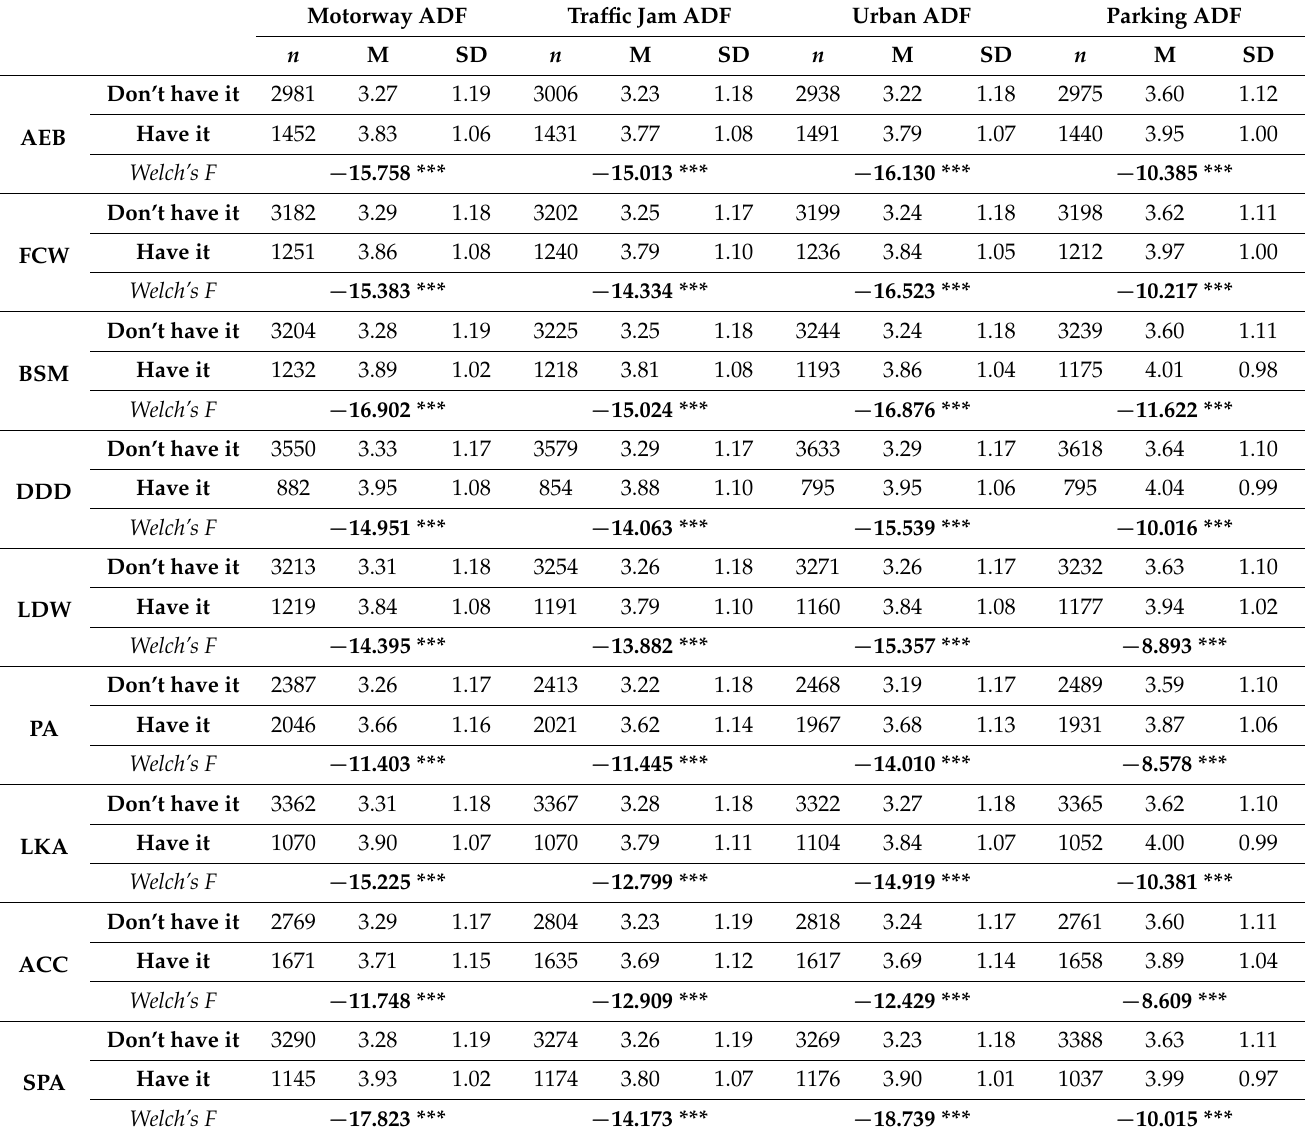
Table 7. Sample size ( n ), mean (M), standard deviation (SD), and independent t-test results for intention to use different ADFs by experience with different ADAS. *** p < 0.001. Motorway ADF Traffic Jam ADF Urban